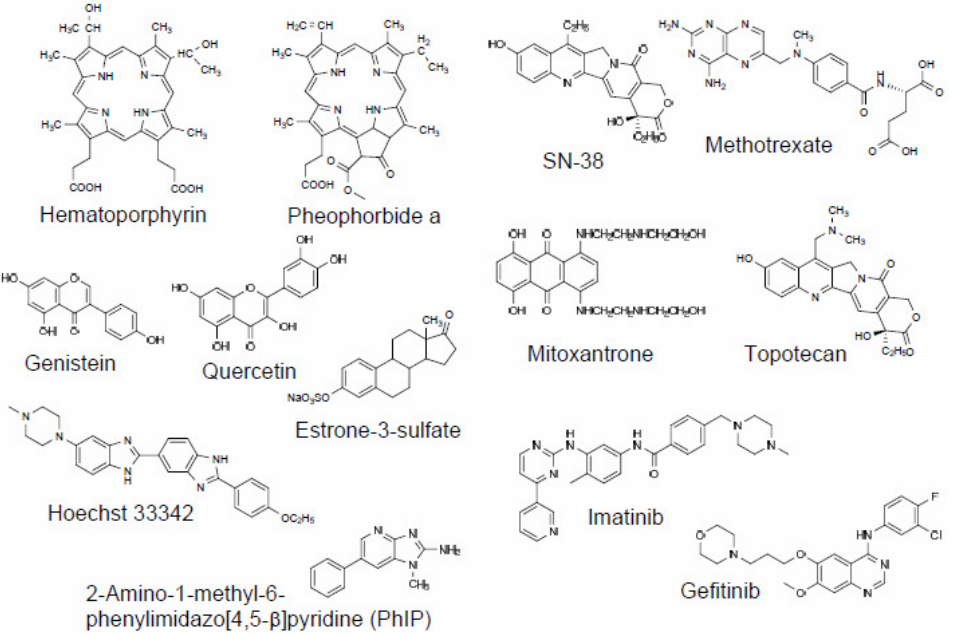
Figure 5. Chemical structures of ABCG2